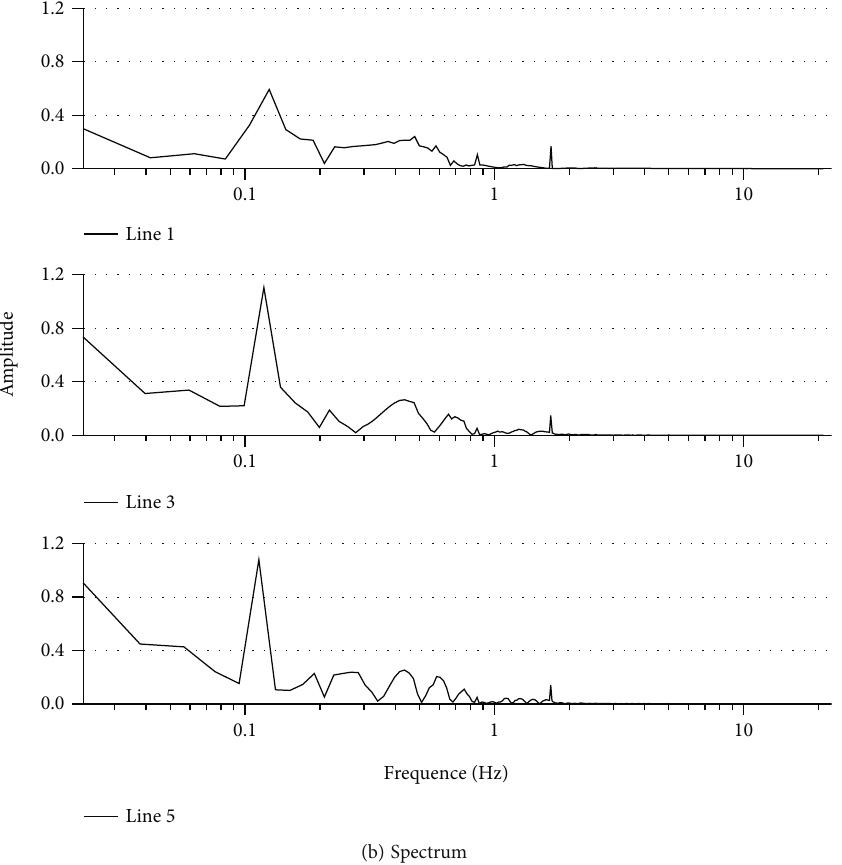
Figure 10: The angle curve of